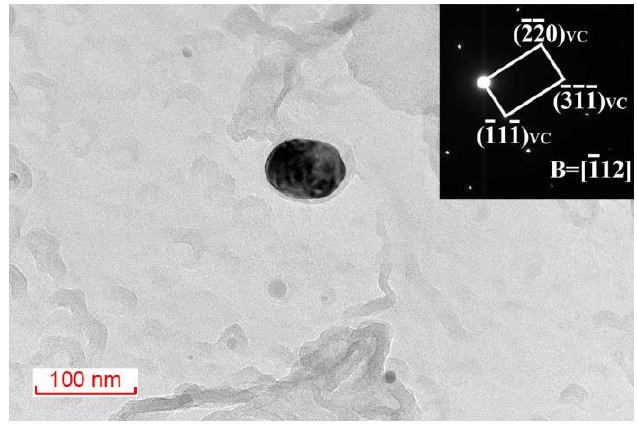
10 of 16 Figure 11. TEM micrographs of 0.16V-2ST_200 specimen: ( a ) dislocation tangle and lath marten- site, ( b ) dislocation network and twin martensite, ( c ) vanadium carbide and ( d ) dislocation-VC interaction. 3.5. Particle Size Distribution Analysis Figure 12 shows the TEM micrograph of VC precipitate with a face-centered cubic structure confirmed by SEAD pattern. To quantitatively study the precipitation behavior of VC, the PSD was analyzed based on more than ~200 VC precipitates for the specific Q&P heat-treatment. TEM micrographs of carbon extraction replica specimens for PSD analysis are presented in Figure 13. A comparison of the determined size distribution of VC in specimens 0.03V-2ST_200, 0.16V-2ST_90 and 0.16V-2ST_200 is shown in Figure 14. Table 4 lists the corresponding information of minimum, maximum, average diameters ( 𝐷 𝑚𝑖𝑛 , 𝐷 𝑚𝑎𝑥 , 𝐷 𝑎𝑣𝑔 ) and density of VC precipitates (number of VC/μm 2 ). The average di- ameter of VC in 0.03V-2ST_200 specimen is quite small with most of the carbides distrib-